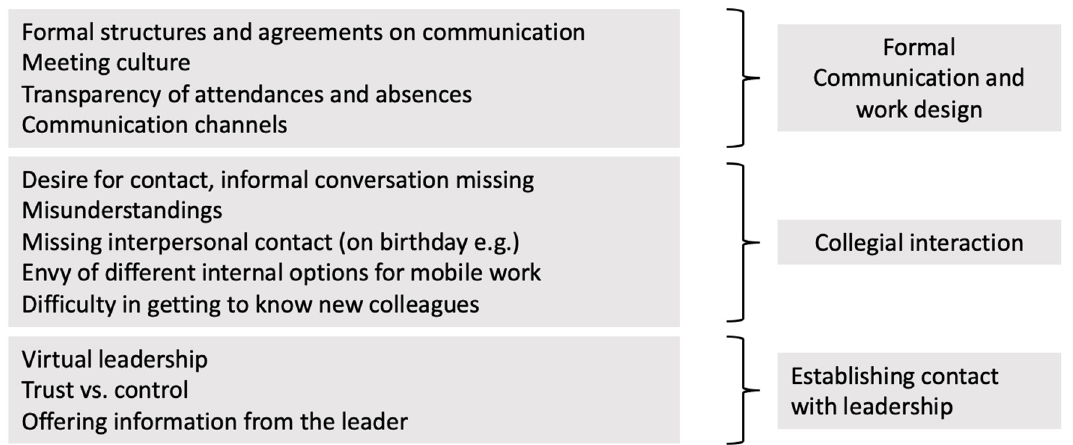
Figure 4. The differentiation of the content of the main code “social interaction”.